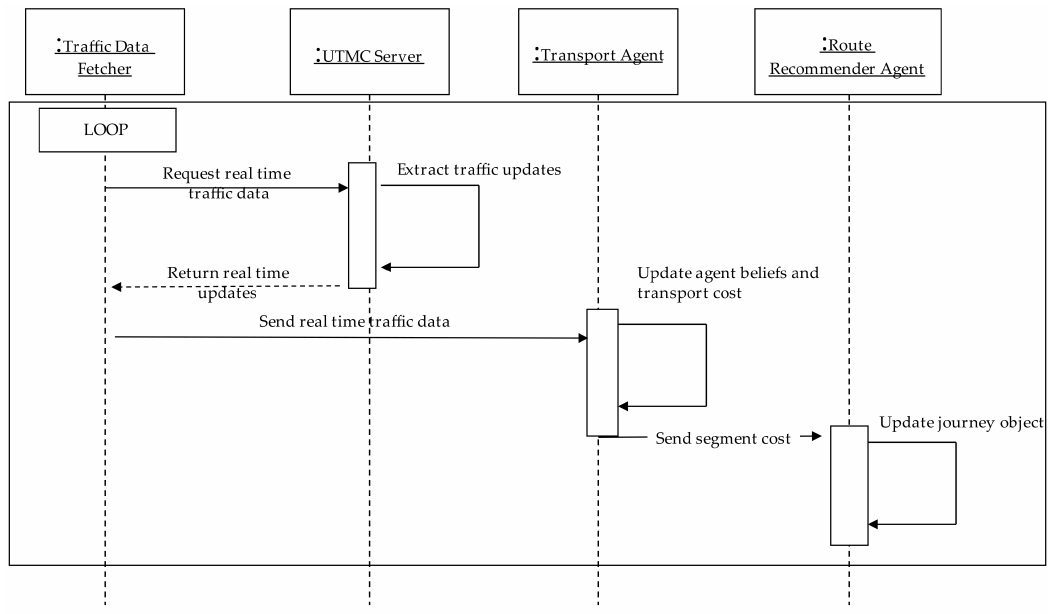
Figure 5. A traffic updates message sequence. UTMC, urban traffic management and